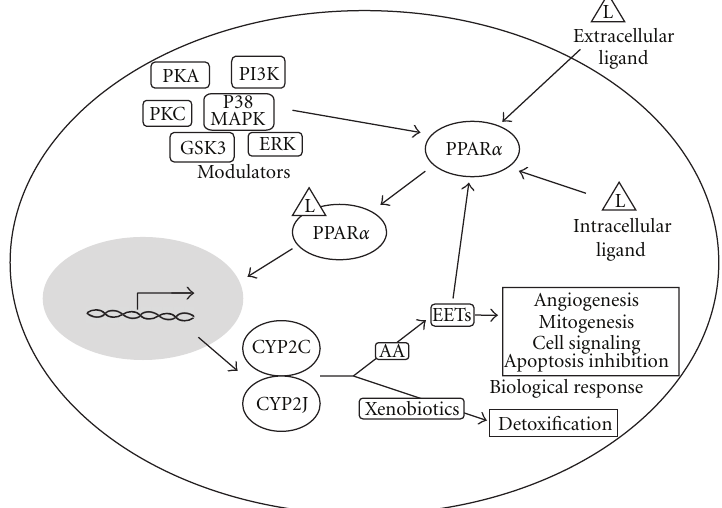
Figure 2: Our proposed model of PPAR α e ff ect on CYP2C and CYP2J (simplified): activation of PPAR α results in CYP2C and CYP2J expression. CYP2C and CYP2J convert arachidonic acid (AA) to EETs, which have cytoprotective function and also can serve as PPAR α ligand, resulting in feedback mechanism. CYP2C and CYP2J also metabolise